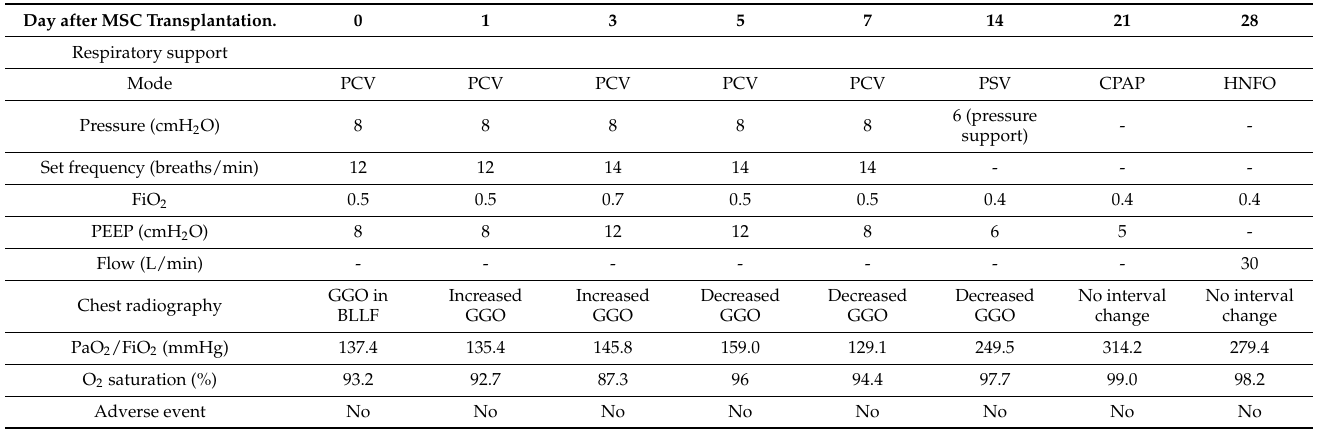
Table 1. Respiratory support method, chest radiography findings, arterial blood gas analysis results, and adverse events on the day of follow-up after MSC transplantation.